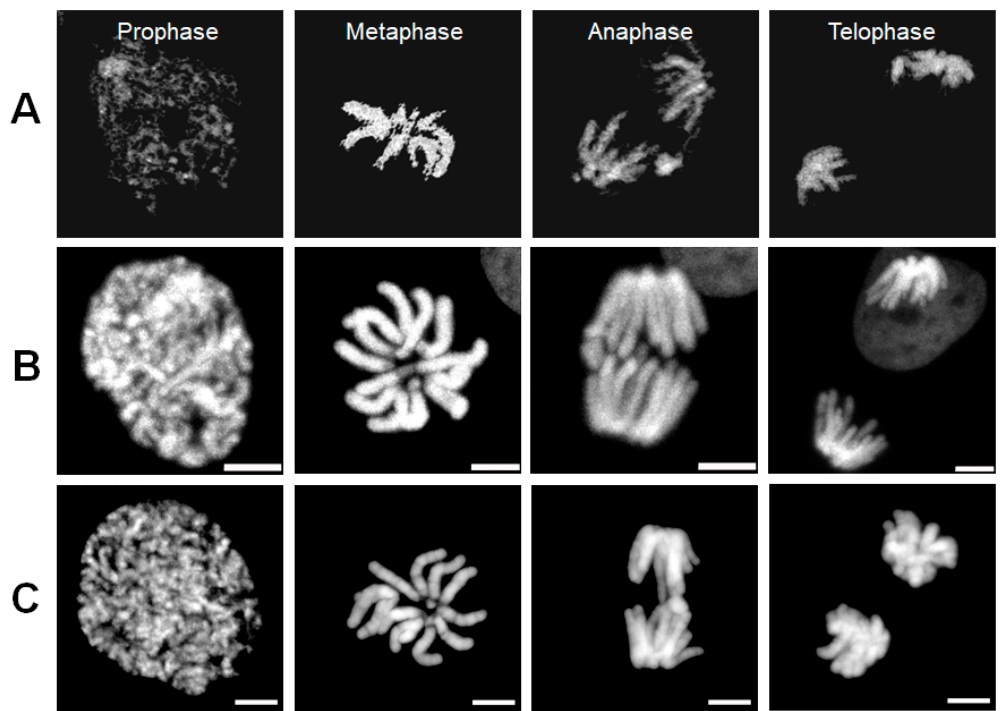
Figure 1. Comparison of 3D confocal fluorescence images of the H2B marker protein tagged with monomeric RFP (H2B-mRFP) with 3D RI images of chromosomes during mitosis. ( A ) Four RI images of a DM cell stably expressing H2B-mRFP and monomeric green fluorescent protein (mGFP) from a series of time-lapse observation during mitosis. For clarity, only high and continuous RI regions of chromosome in mitotic cytosol are shown (see also Supplementary Movie 1). ( B ) Four fluorescence images of H2B-mRFP from a series of time-lapse and 3D observations depicting mitosis in a DM cell stably expressing H2B-mRFP and mGFP. For clarity, images from mGFP channels are not shown. ( C ) Four fluorescence images of mitotic chromosomes of fixed DM cells stained by DAPI. Scale bar = 5 µ μ m.